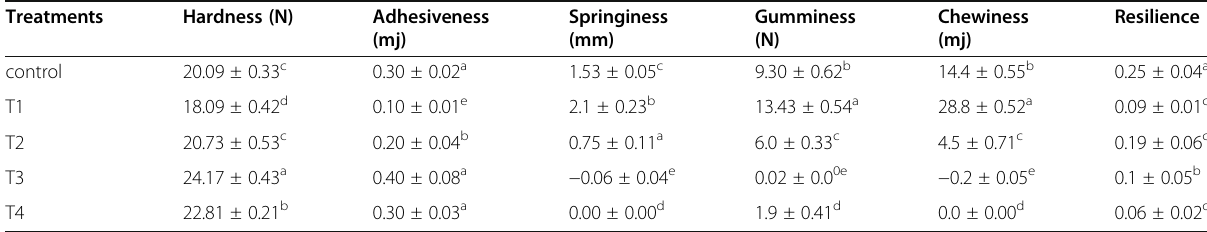
Table 9 Rheology properties of extruded